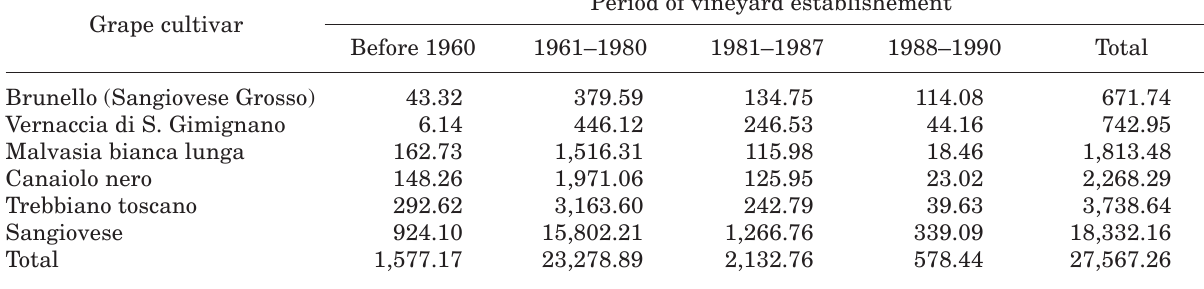
Table 2. Distrubution of Tuscan vineyards by vineyard age group (No. of ha) for some of the main cultivars grown in the Chianti Classico area (Tuscany, Italy) in 1990. As a result of the extensive plantation in the 1960s, 84.4% of the vineyards of the cultivars listed were planted in the twenty years from 1960 to 1980 (IV Censimento Generale dell’Agricoltura, 1990, In: Periccioli,